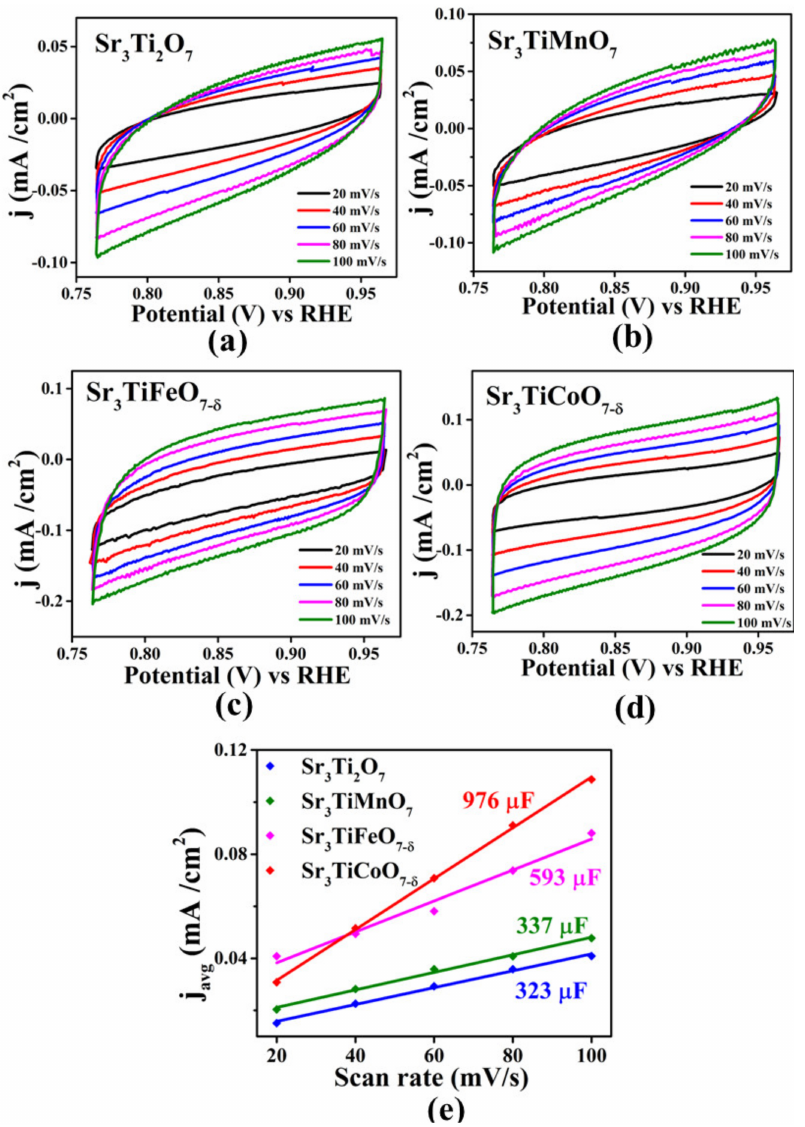
Figure 6. ( a – d ) cyclic voltammetry in non-Faradaic region in 0.1 M KOH; ( e ) j average obtained from these CV plotted as a function of scan